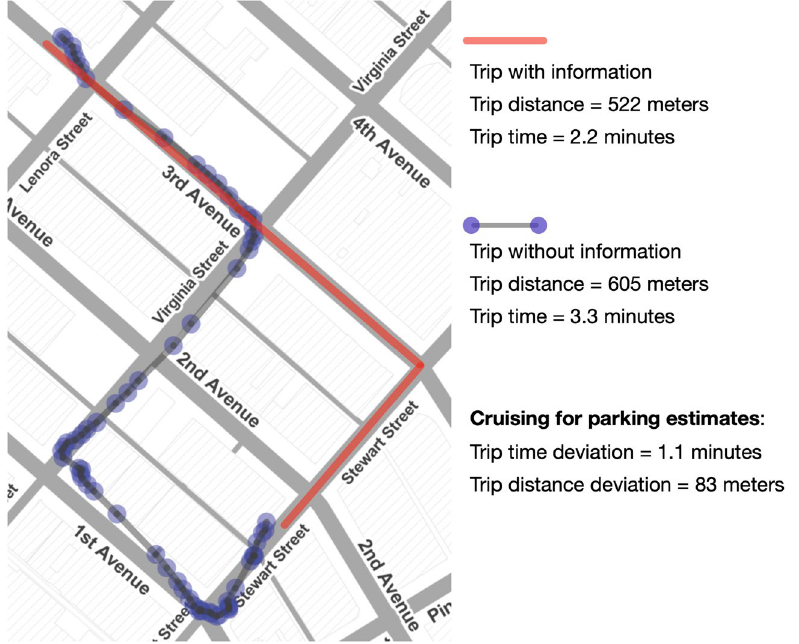
Figure 4. Estimation of cruising for parking time and distance. The map was created using the Leaflet library 31